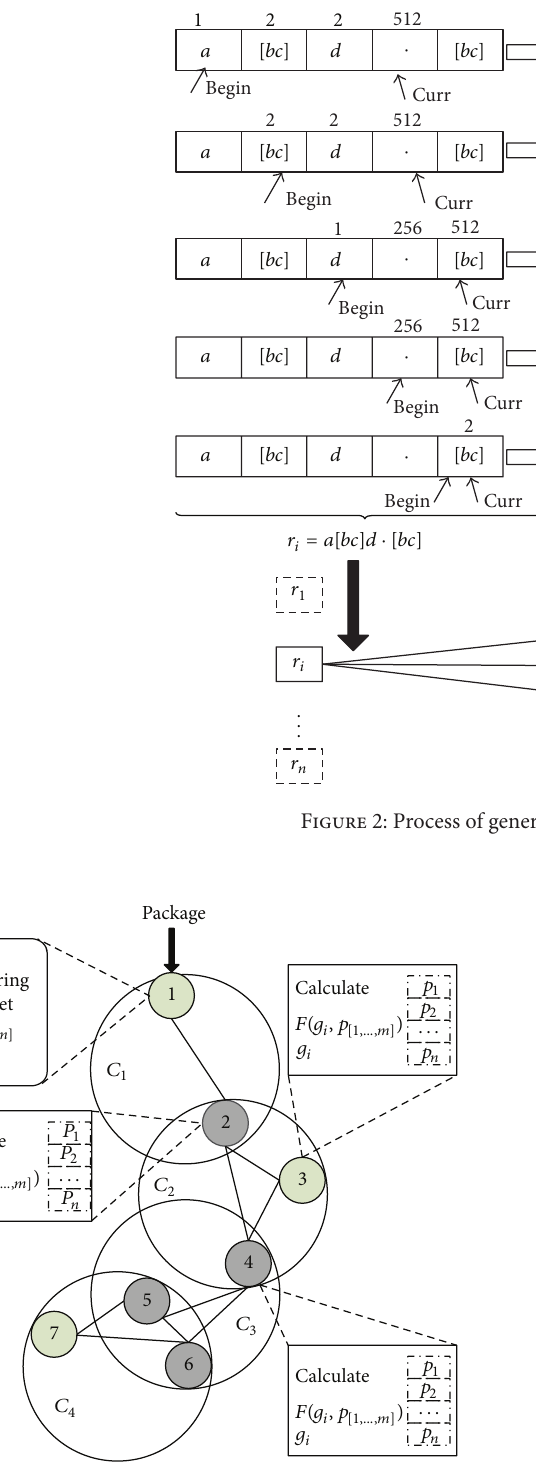
The package matching process is demonstrated in Figure 3. Taking the limited computing power of each wire- less node into consideration, the calculation of 𝐹(𝑔 𝑖 ; 𝑝 [1;...;𝑚]